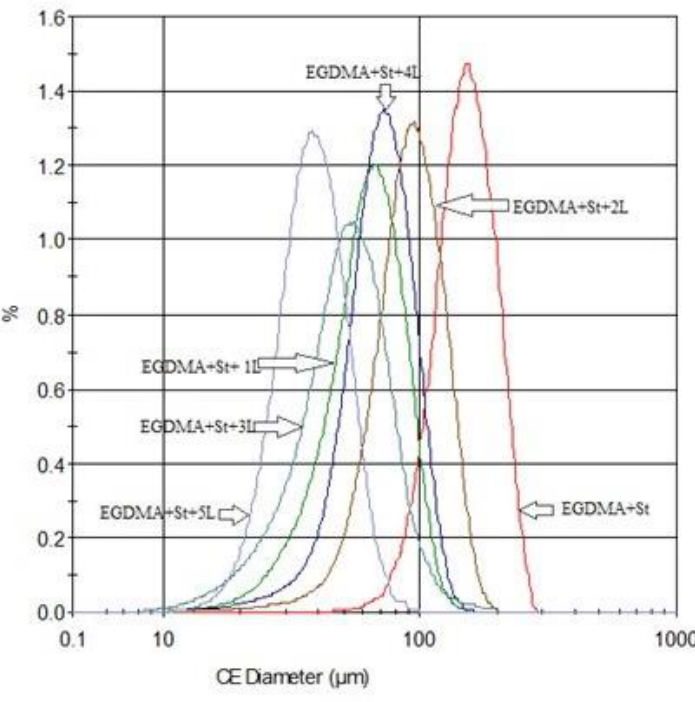
Figure 7. Impact of lignin content on the diameter distribution of microspheres.